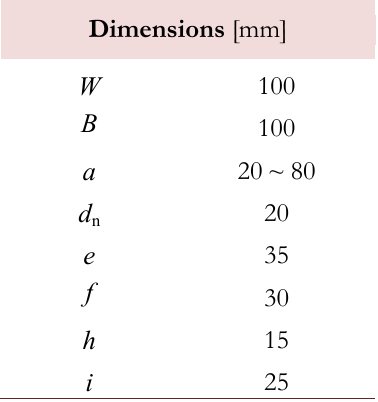
Table 1: Individual dimensions of the modeled WST